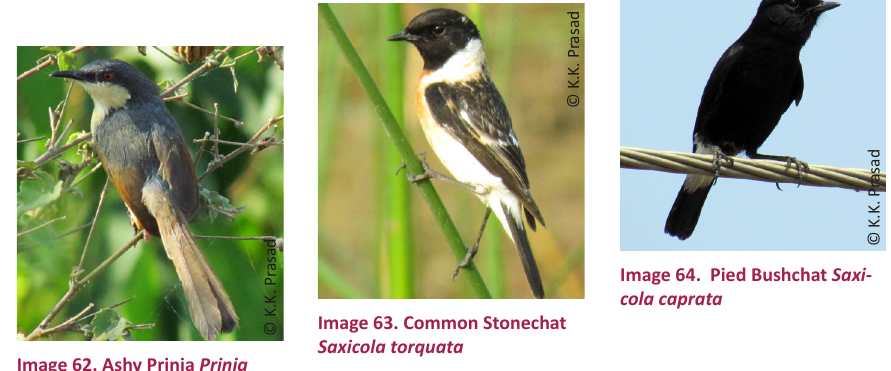
Image 62. Ashy Prinia Prinia socialis